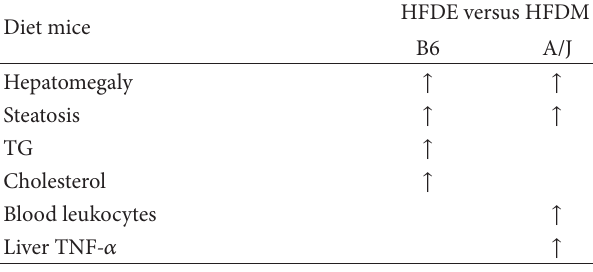
HFDE versus HFDM B6 A/J